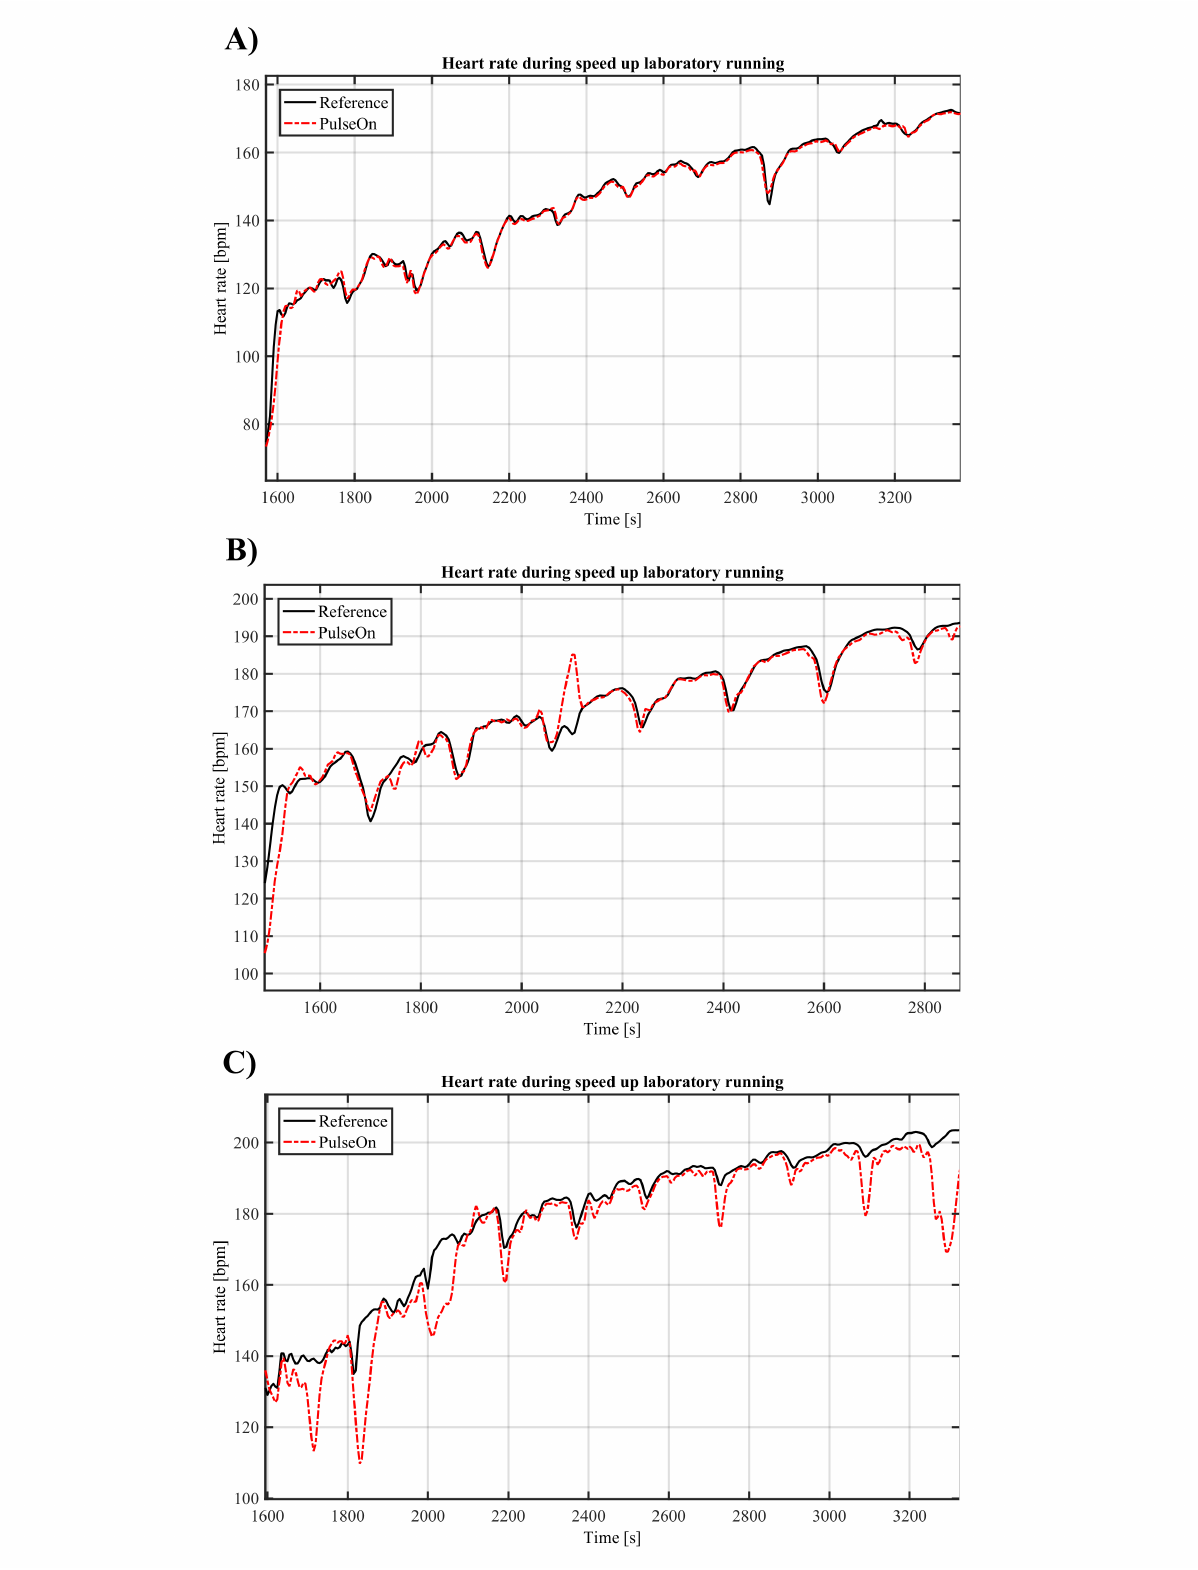
Figure 1. Comparison of HR from chest strap (black line) and wrist PPG device (red line) during maximum exercise test: (A) best accuracy, (B) average accuracy, and (C) worst